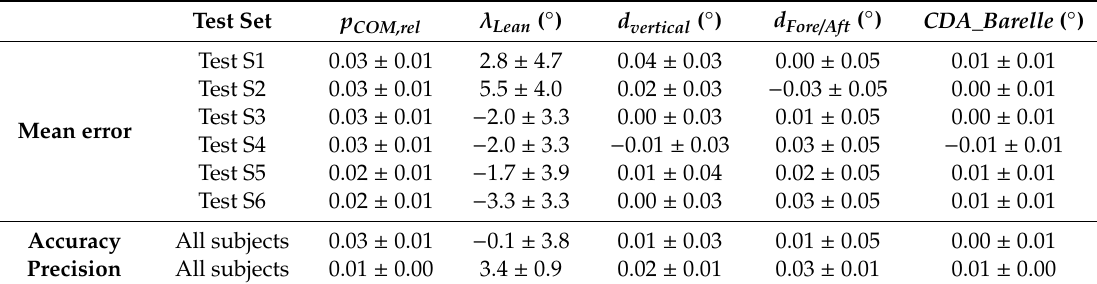
Table 4. The accuracy and precision of skiing-specific metrics based on the monocular 3D reconstruction (averages over the cameras CAM 3 and CAM